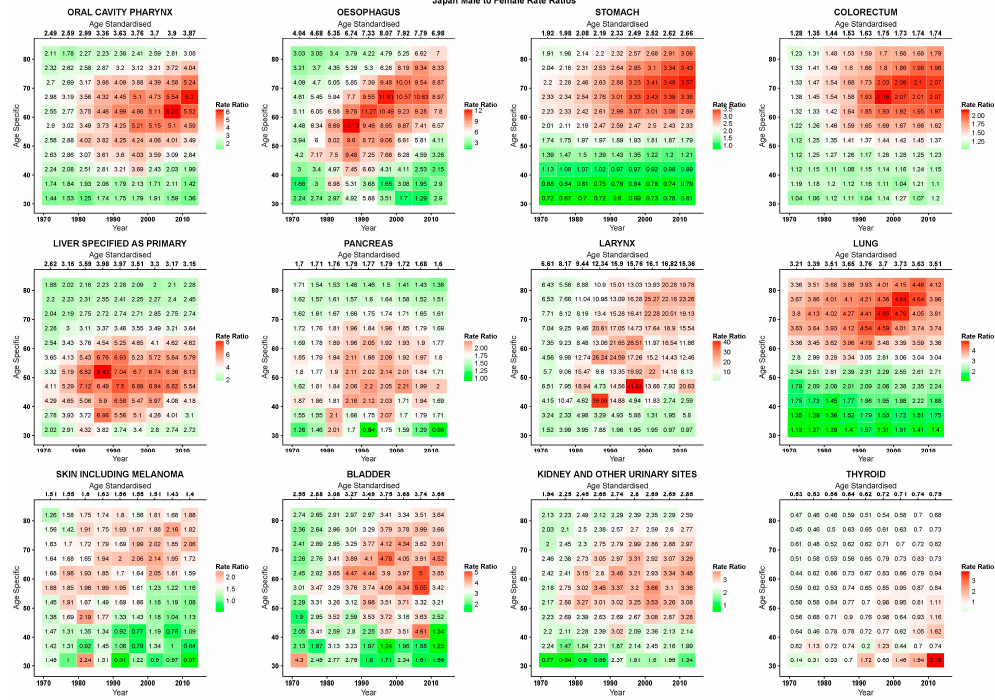
Figure 4. Heatmap tables of age-specific and age-standardised quinquennial male-to-female mortality rate ratios in epithelial cancers in Japan.